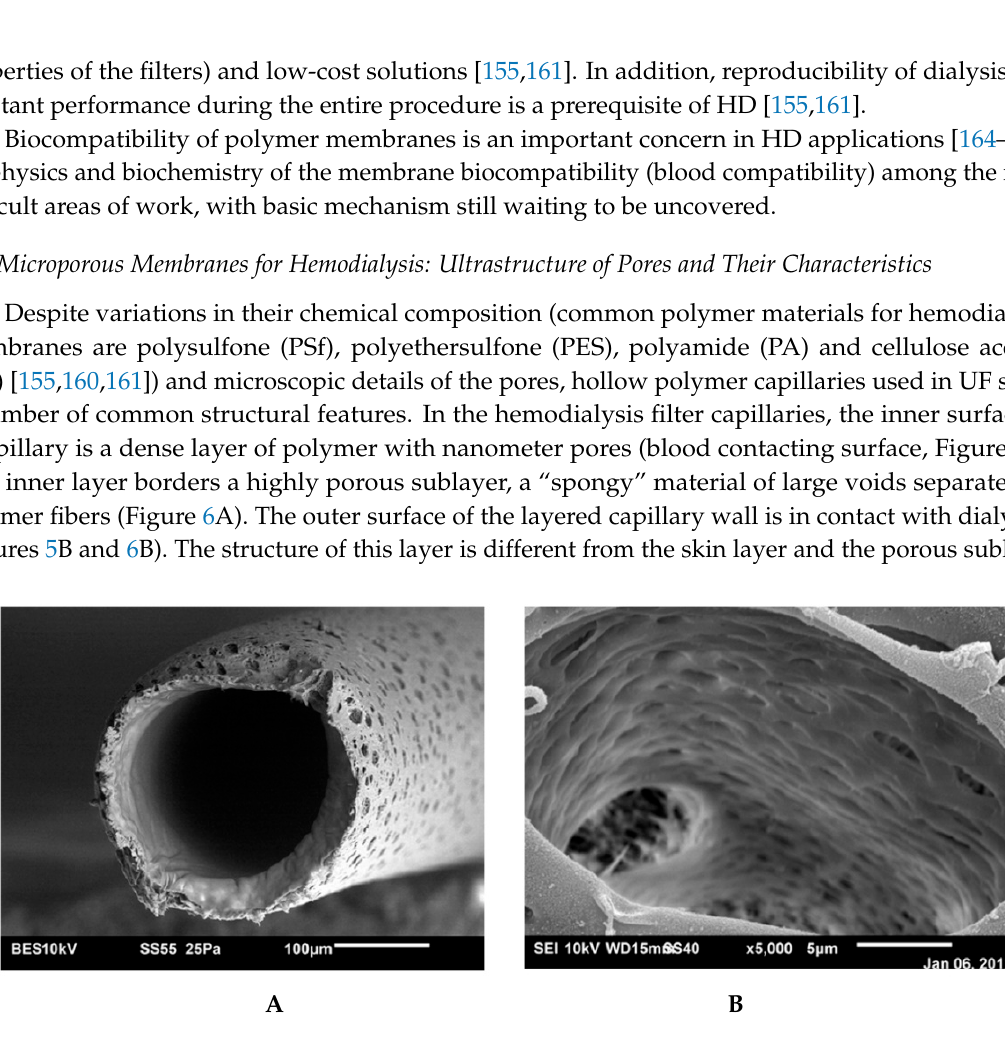
Figure 5. ( A ) SEM of the cross section of a Polyflux capillary at 250×; and ( B ) SEM of a Polyflux capillary wall showing tortuous pore morphology (outside pore in contact with the dialysate) at 5000× (adapted from [160] with permission).